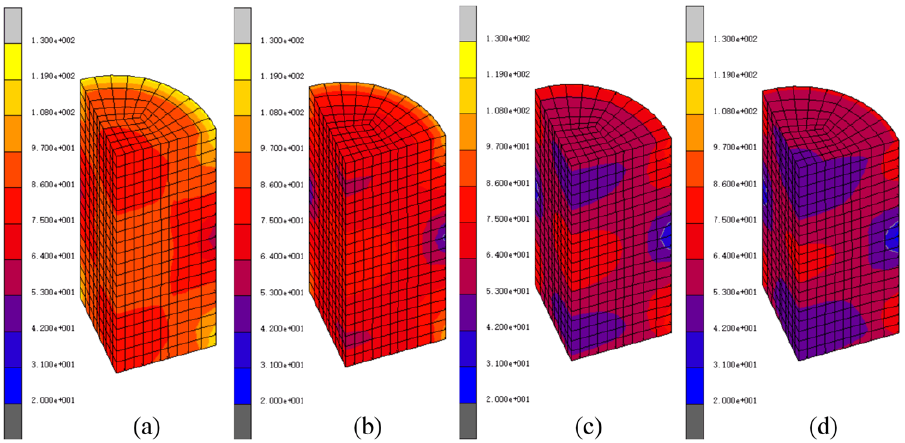
Figure 25. Equivalent von Mises stress distributions in compact at a compaction pressure of 200 MPa for various dwell times at ( a ) t = 0 min, ( b ) t = 3 min, ( c ) t = 10 min, and ( d ) t = 15 min.